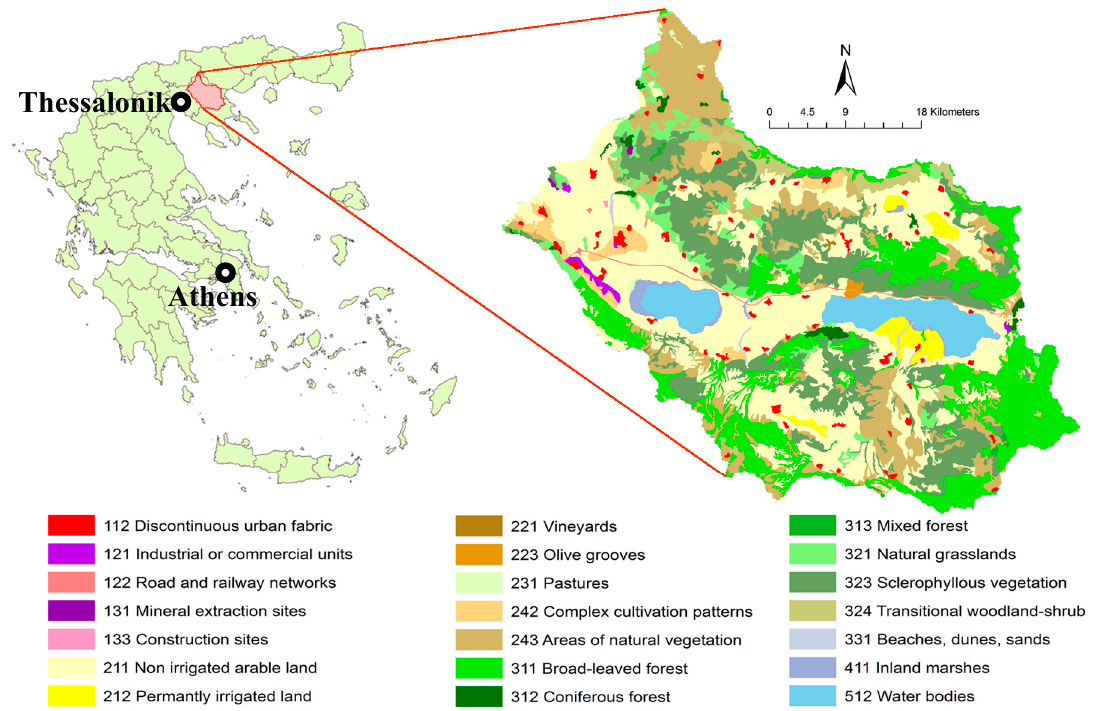
Figure 1. The National Park of Koronia and Volvi Lakes (NPKV) lies in the Mygdonia basin, northern Greece. The detail shows the land uses according to Corine Land Cover (CLC) 2012.